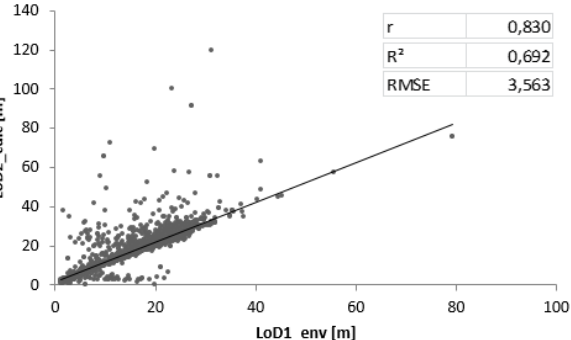
Figure 7. LoD1_env height information plotted against LoD2_calc height information.